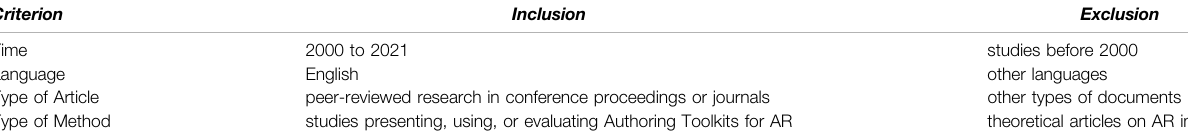
TABLE 1 | Inclusion and exclusion criteria. Criterion